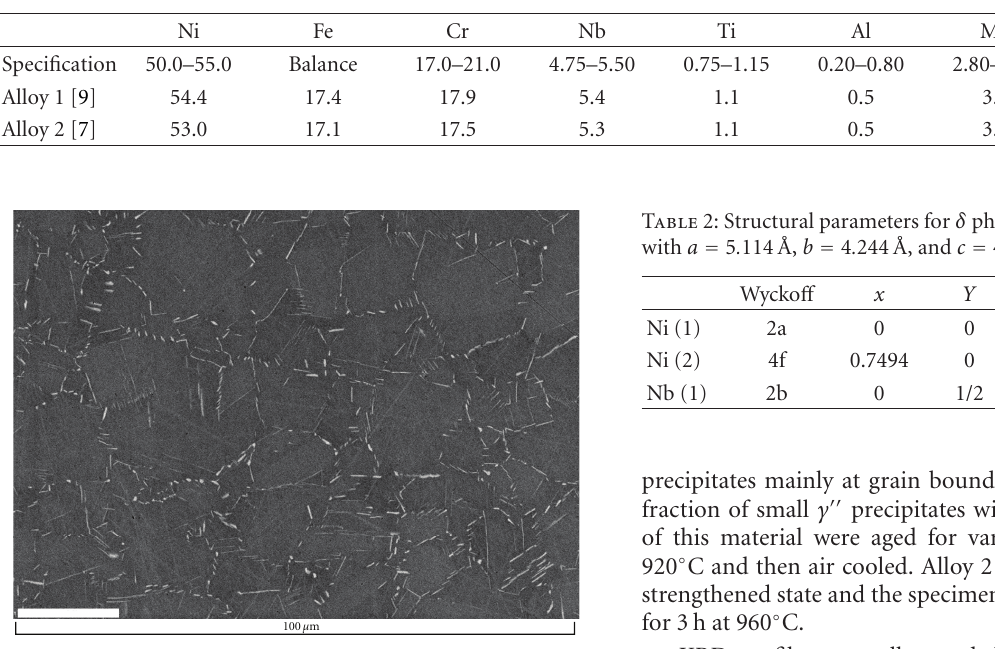
Figure 1: SEM micrograph showing mainly cellular (grain bound- ary) and some intragranular precipitation of delta phase in a sample held for 1h at 960 ◦ C.